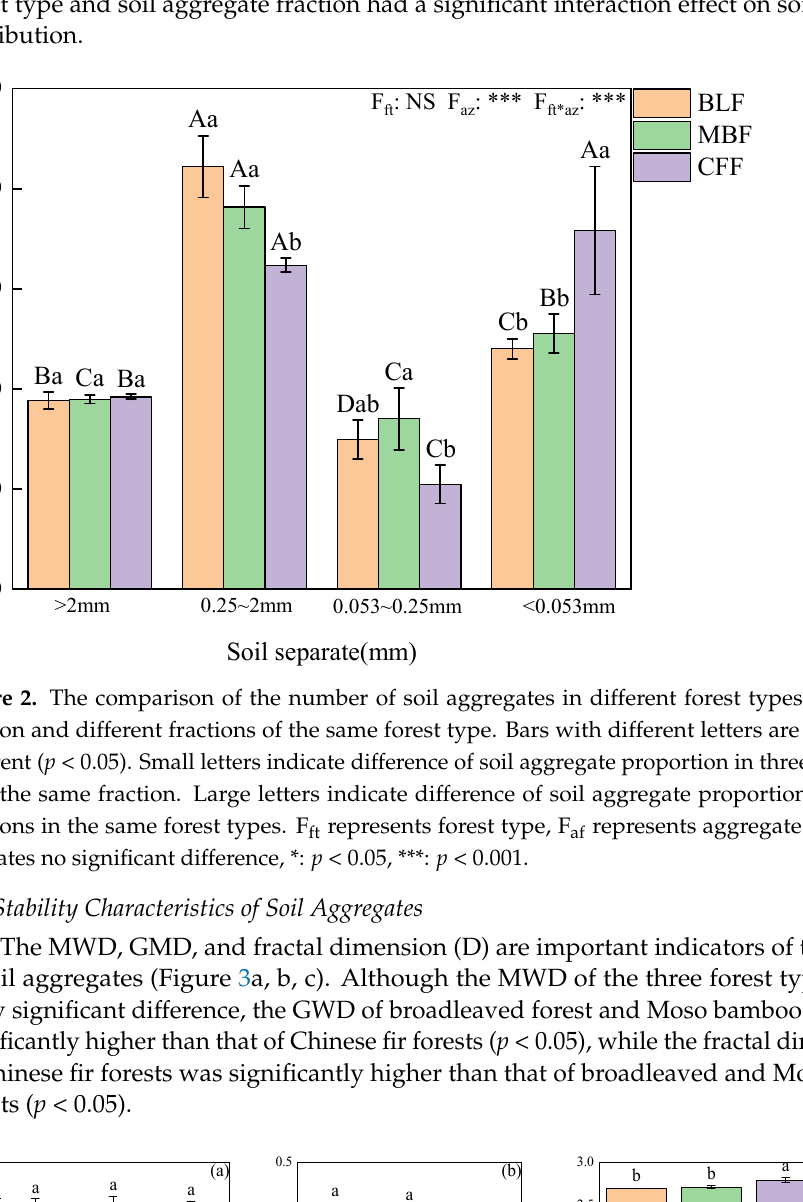
boo forests ( p < 0.05).